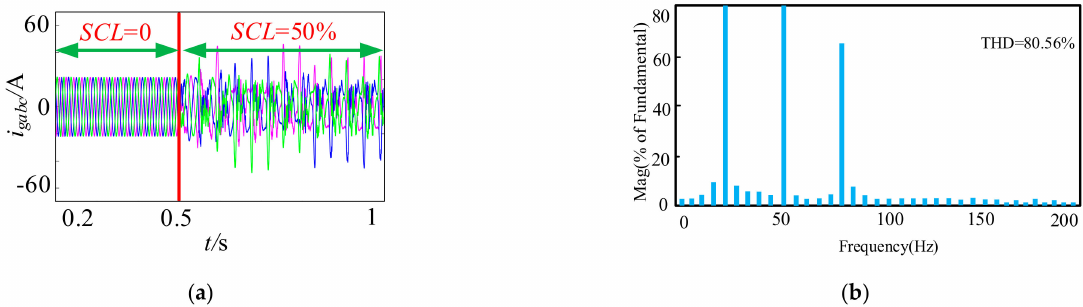
Figure 5. Simulation results with different SCL . ( a ) Grid-connected current waveform, ( b ) spectrum of the current when SCL =